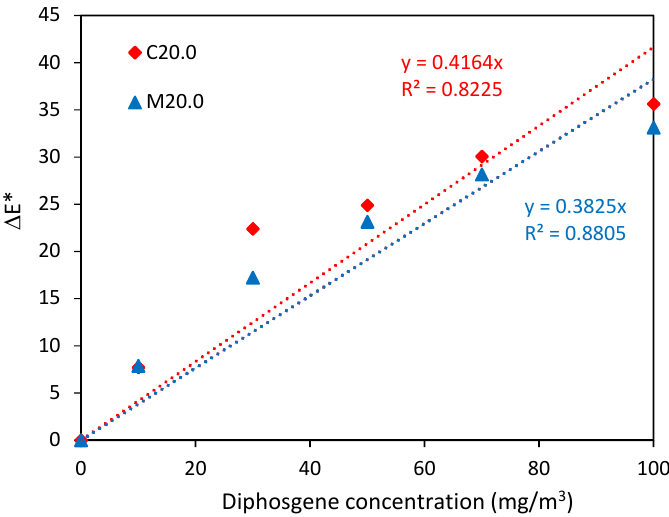
Figure 4. Dependence of the M20.0/PY ‐ OPD charge VIS/UV color intensity on the concentration of diphosgene (the air volume was 1 dm 3 ).